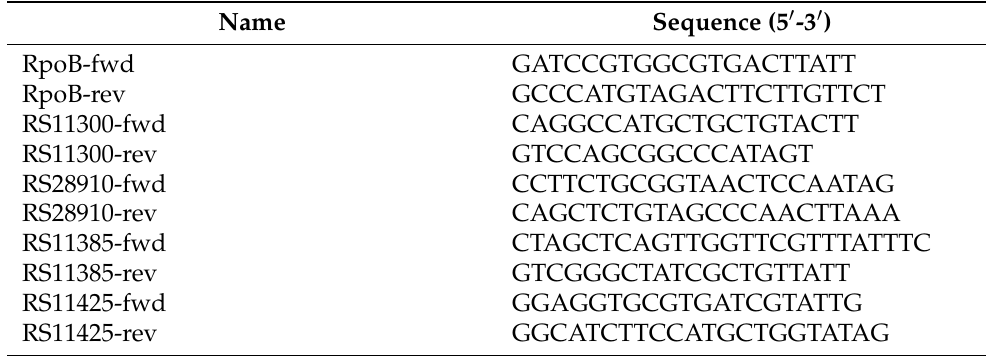
Table 5. Sequences of the primers used for